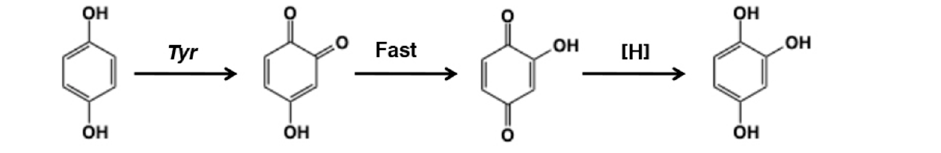
Figure 17. Reaction of hydroquinone in the tyrosinase-catalyzed oxidation [77,80,81].